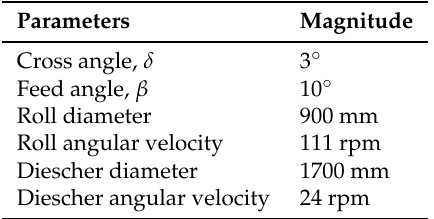
Table 2. Parameters of the rotary piercing mill FE model